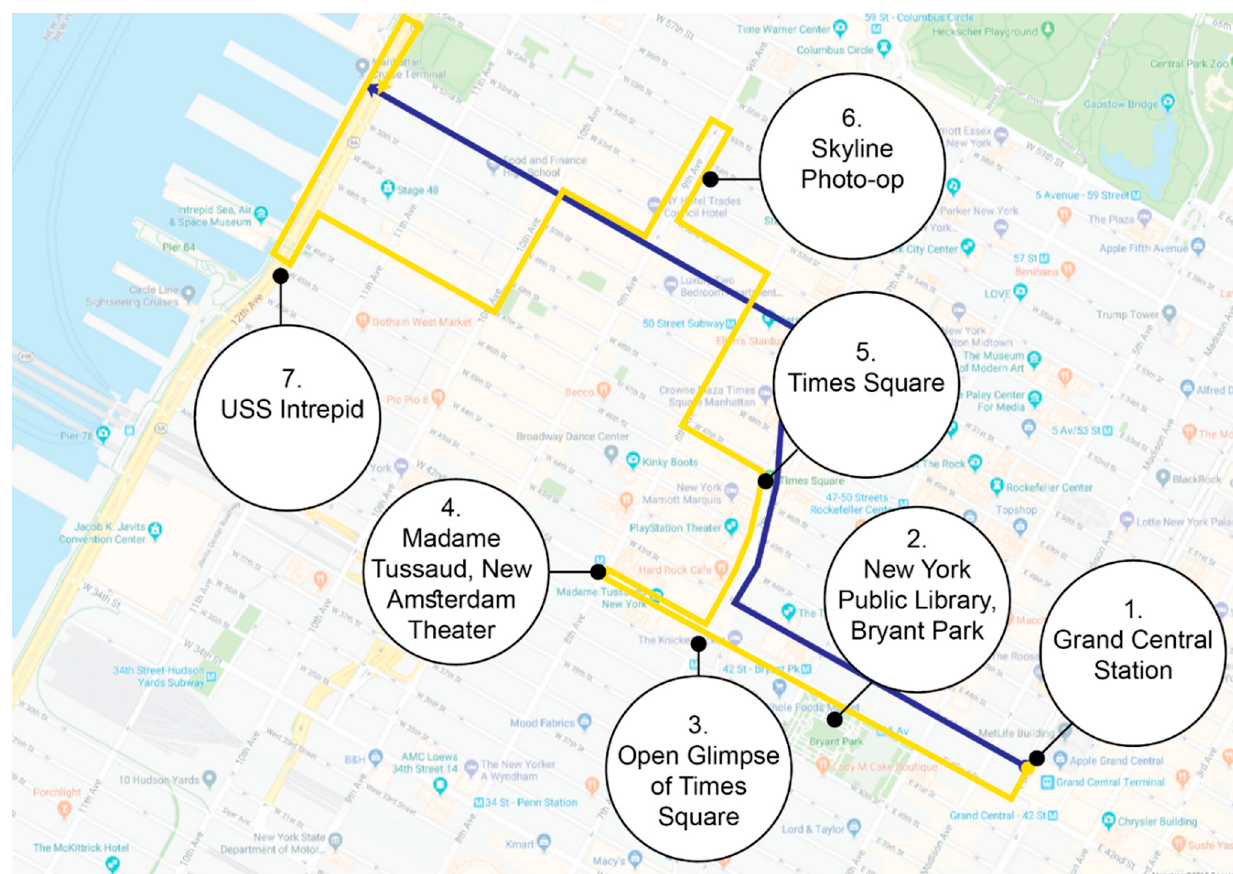
Figure 7. Tourism walking route in Manhattan (case study 1) computed by our algorithm (yellow) and the shortest path according to Google Maps (blue), with the identified landmarks and attractions along the routes (background: Google Maps).